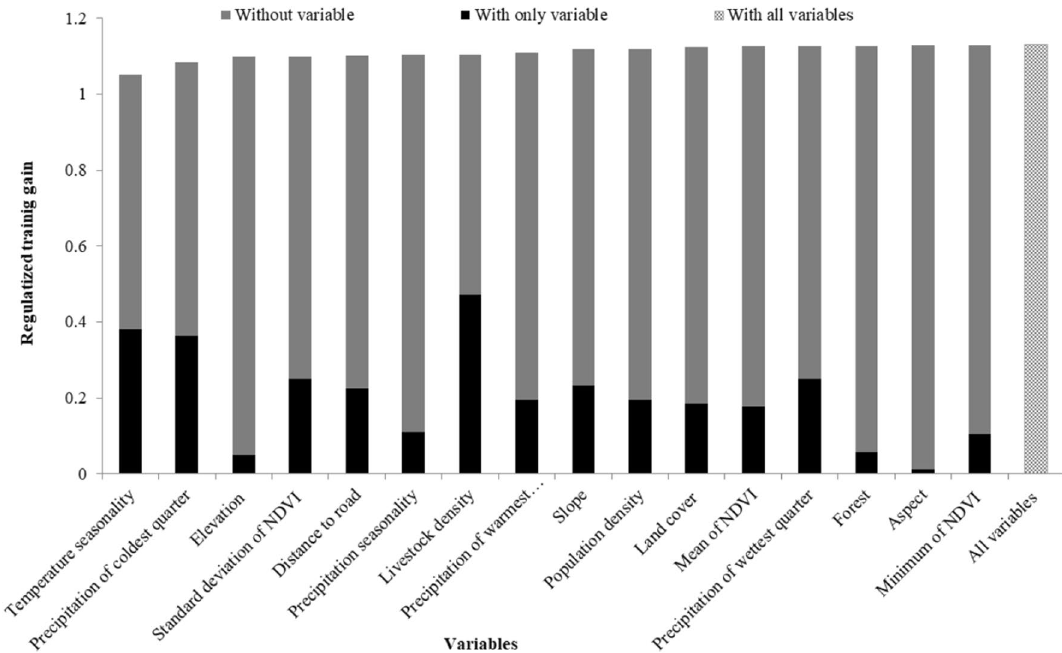
Figure 2. Importance of environmental variables for modelling the distribution of the Egyptian vulture. The black bars show the regularized training gain when only that variable is included in the model; the grey bars show the regularized training gain when all other variables except that variable are included in the model. The patterned bar is the reference regularized training gain when all variables are included in the